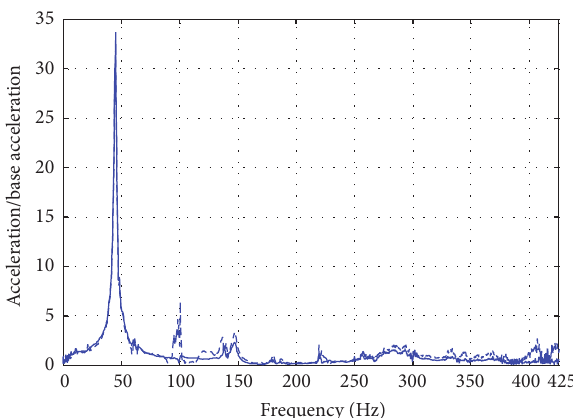
Figure 18: The acceleration transmissibility measured from the experiment for the case of no friction and a thick secondary beam. Solidline:accelerationattheendofthefirstbeam(sensor2).Dashed line: acceleration at the end of the secondary beam (sensor